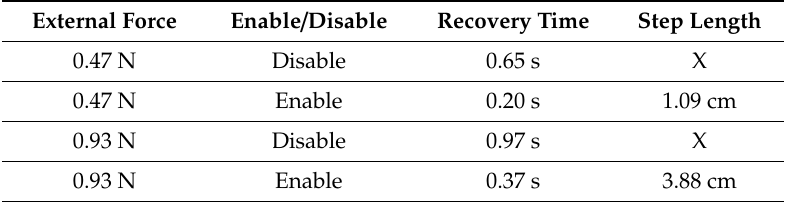
Table 5. Experimental results of the proposed method with the stepping backward enabled and